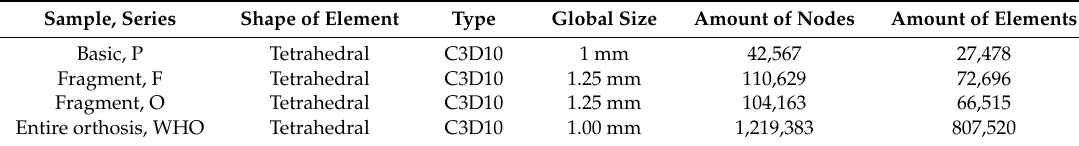
Figure 7. Finite element mesh superimposed on the test specimen in the shape of the entire orthosis of high geometric complexity (partial view). Table 3. Parameters of the applied finite element mesh on the test samples.